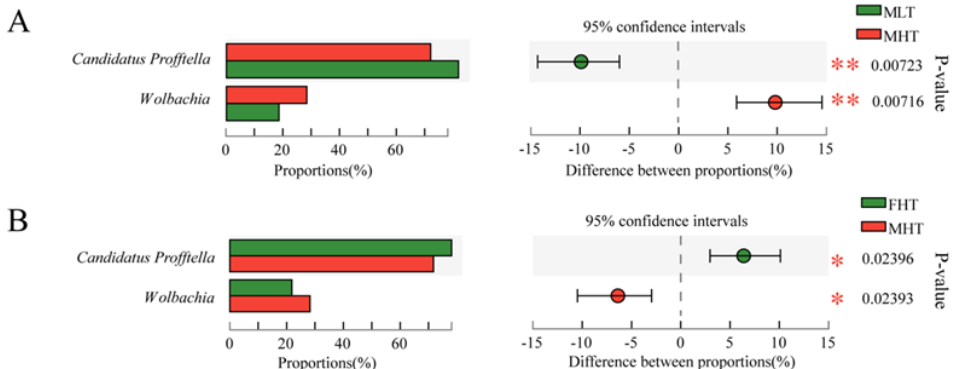
Figure 4. Comparison of the bacterial community in MLTs and MHTs and in FHTs and MHTs. ( A ) Males in low – and high – temperature treatments. ( B ) Females and males in high-temperature treatments. Student’s t – test was used to statis- tically determine the significant differences between males and females of D. citri under low – temperature or normal – temperature treatments (* p < 0.05; ** p < 0.01). FHT and MHT: female and male under high temperature (42 °C); MLT: male under low temperature (15 °C). Every group had four biological replicates of D. citri .